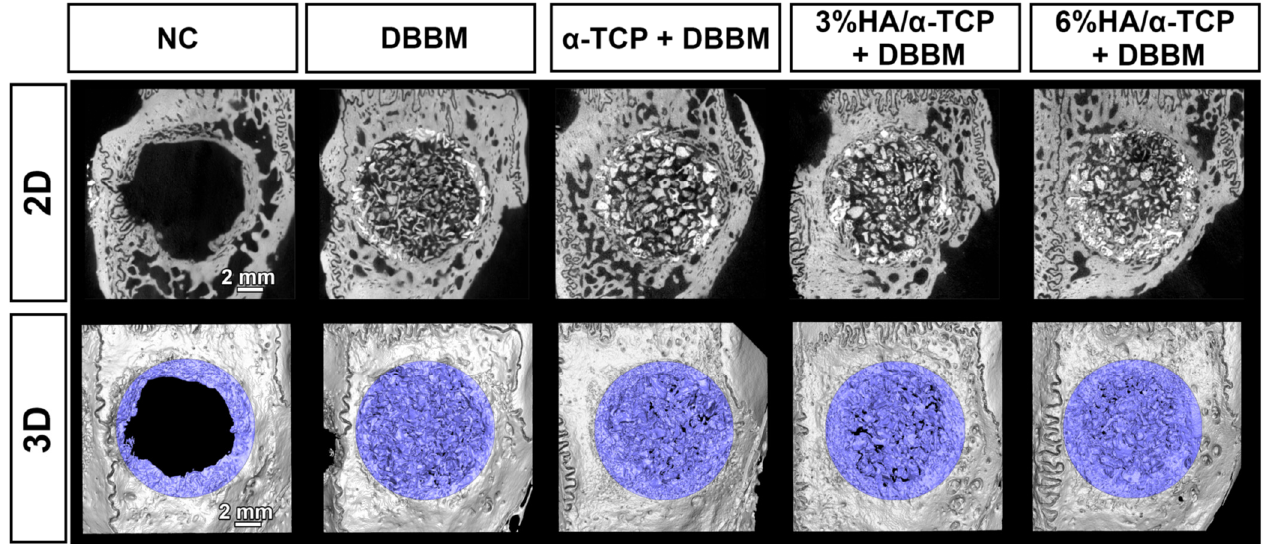
Figure 2. Micro-CT images of each group; 2D plane ( upper row ) and 3D-reconstructed views ( lower row ); the blue color shows mineralized tissue in the bone defects). Homogenously distributed mineralized structures comprising bone substitute materials and newly formed bone were observed in the defects. Scale bar: 2